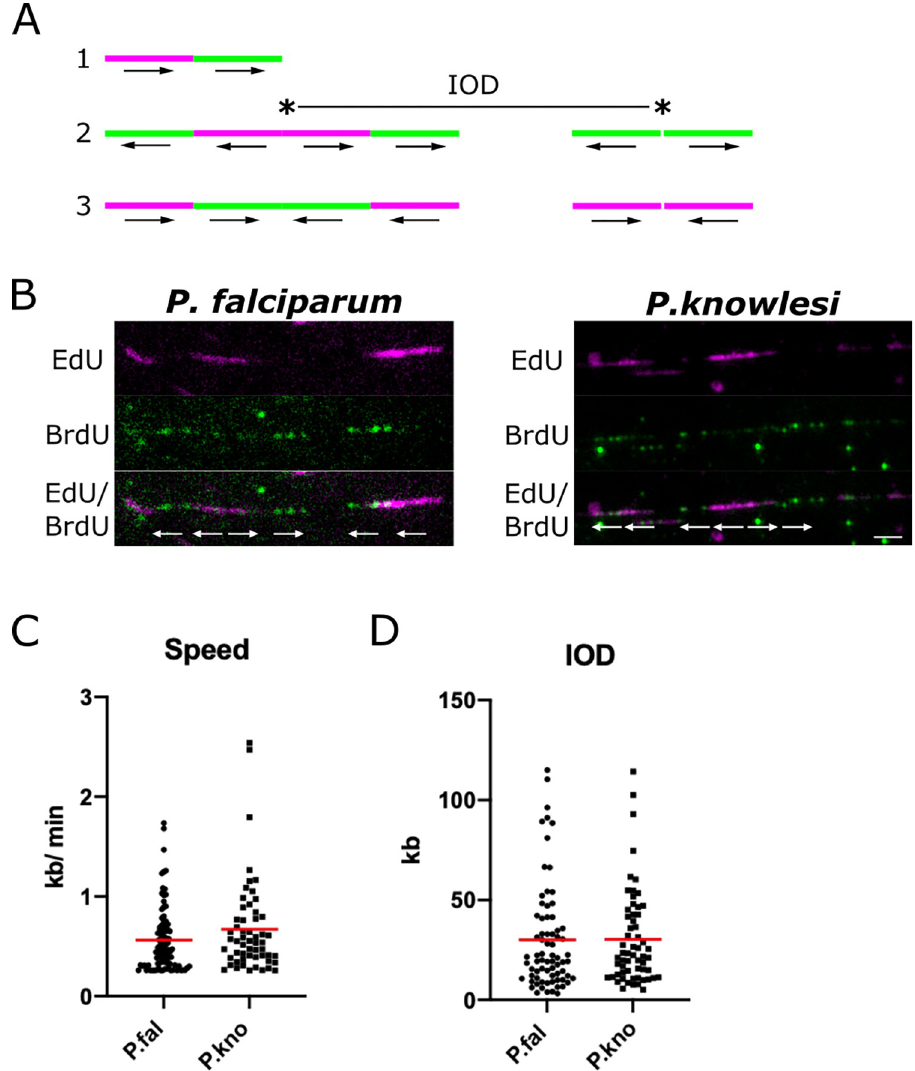
Fig 7. Single-molecule DNA replication dynamics in P . falciparum and P . knowlesi . A: Schematic showing possible patterns of labelling on DNA fibres. Pattern 1 is an ongoing replication fork, moving throughout the two consecutive pulse-labels. Pattern 2 shows origins that fired during the first and second pulse labels, with inter-origin distance (IOD) measured as centre to centre distance between two adjacent origins. Pattern 3 shows two replication forks terminating during the first or second pulses. The presumed positions of the replication origins are indicated with asterisks in the middle of bidirectional replication forks. Arrows represent the direction of the replication forks’ progression. B: Representative DNA fibre spreads from P . falciparum and P . knowlesi . A 5kb scale bars is indicated. C: Dot plot showing distribution of replication fork speeds in P . falciparum and P . knowlesi , calculated on the basis of a 20-min pulse label (10 mins EdU, 10mins BrdU) and a stretching factor of 2.59kb/ μ m. Red bars represent the mean value. D: Dot plot showing distribution of inter-origin distances (IODs) in P . falciparum and P . knowlesi , calculated on the basis of a stretching factor of 2.59kb/ μ m. Red bars represent the mean value.